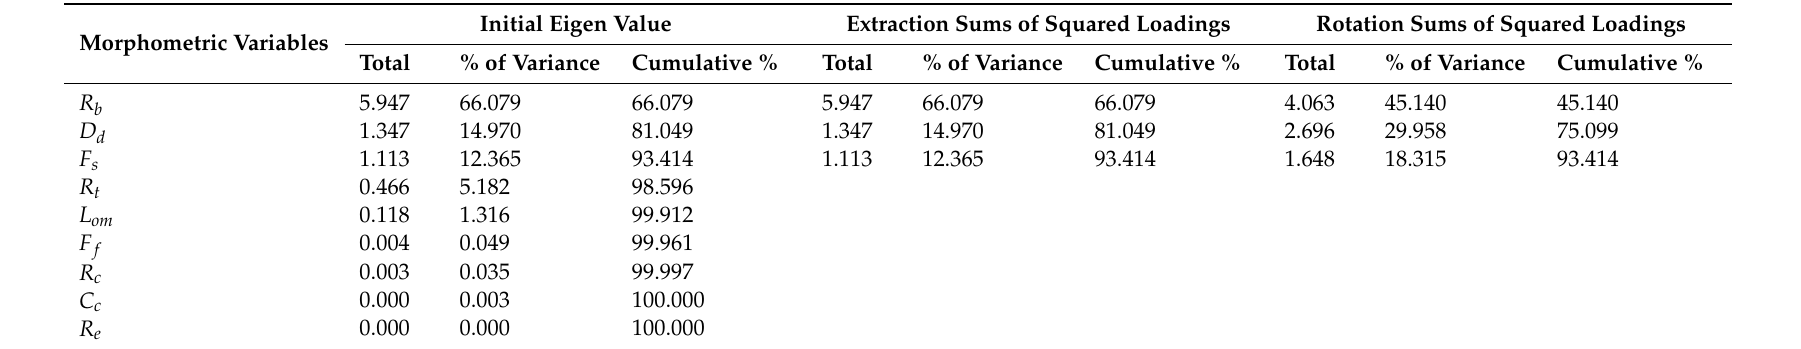
Table 8. Total variance explained for